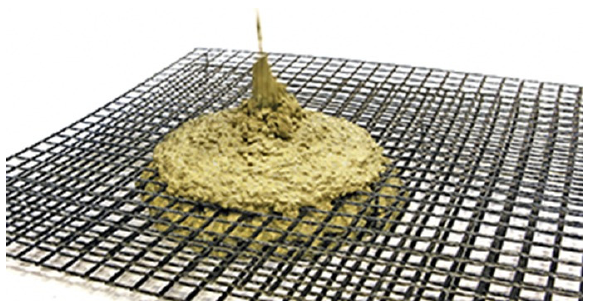
Figure 3. Illustration of the flow process of the fresh concrete through and between the layers of close-knit carbon fabric reinforcement. Reprinted with permission from ref. [44]. Copyright 2017 Beton und